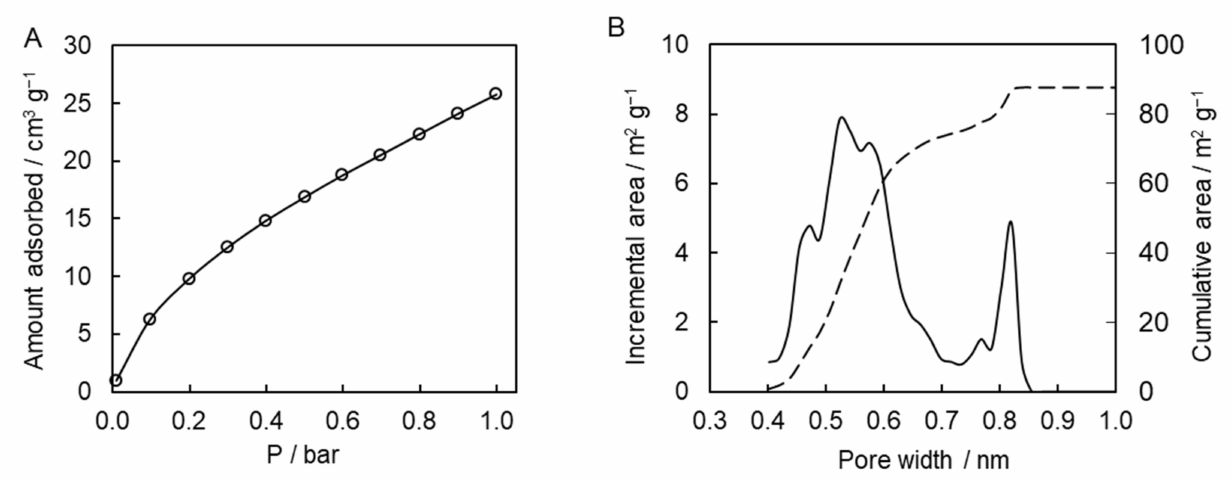
Figure 8. Adsorption isotherm for carbon dioxide at 0 ◦ C ( A ); incremental and cumulative pore-size distribution curves ( B